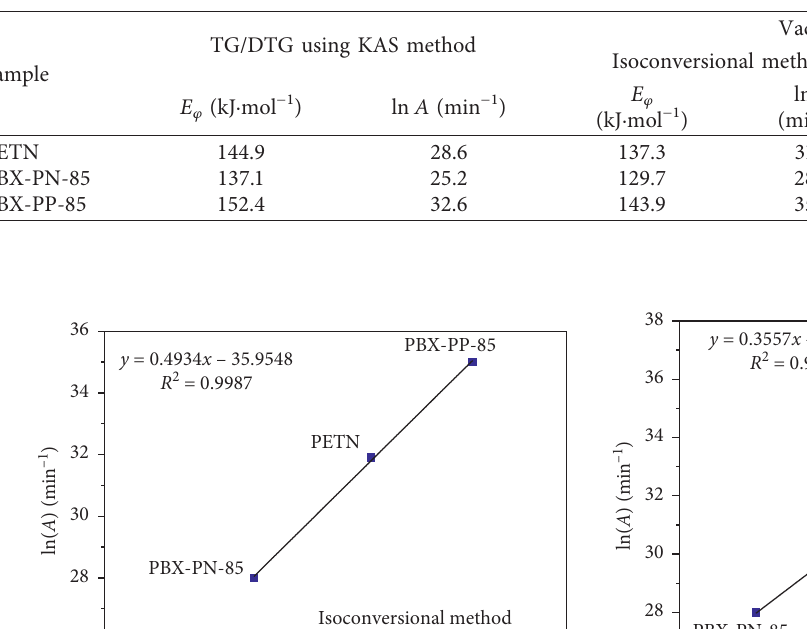
Table 7: Kinetic parameters of PETN and PBXs obtained by several methods.